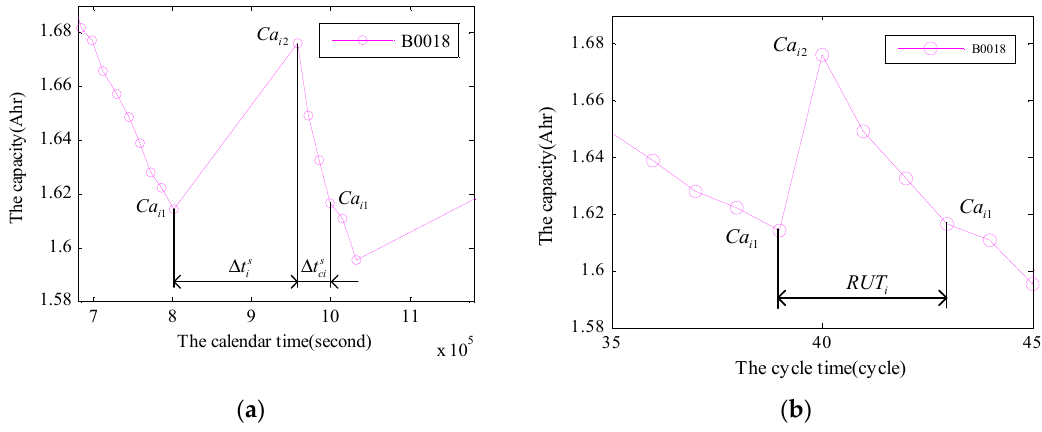
Figure 2. The example of recovery process: ( a ) With calendar time; and ( b ) with cycle time.